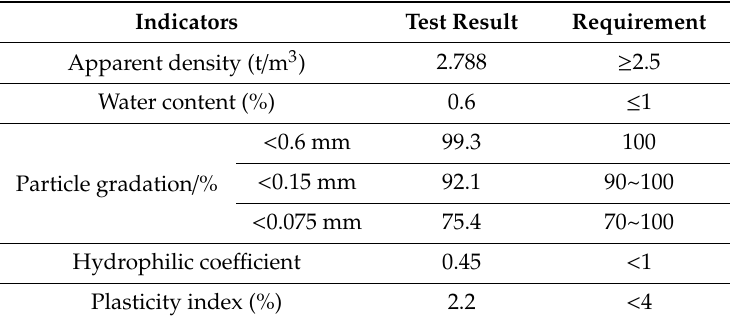
Table A3. Technical indicators of mineral